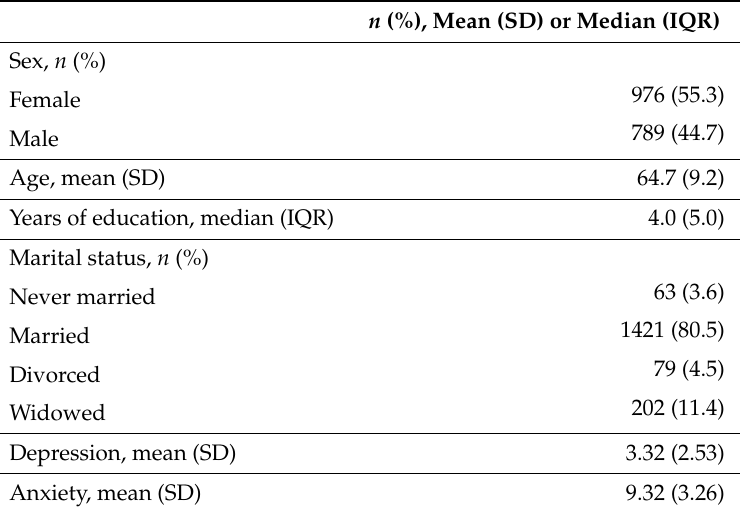
Table 1. Baseline sample characteristics.